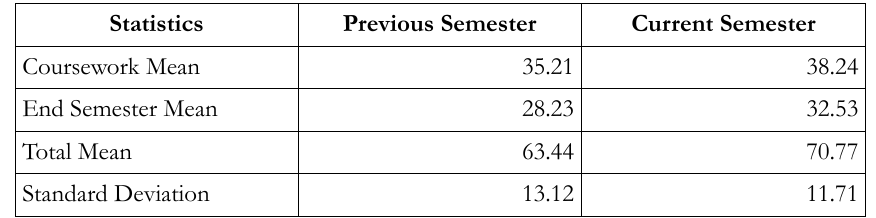
Table 1. Student scores during previous and current